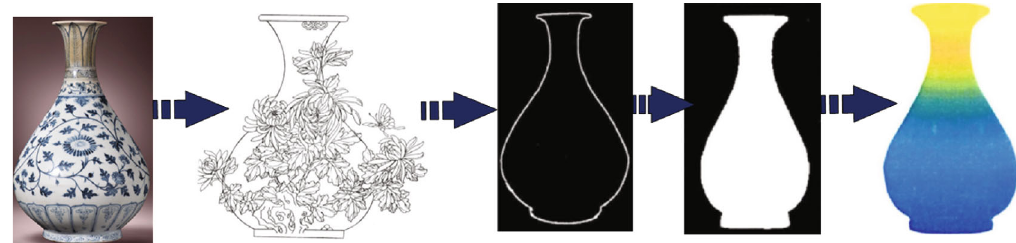
Figure 3: Steps of three-dimensional image modeling of jade pot spring bottle.